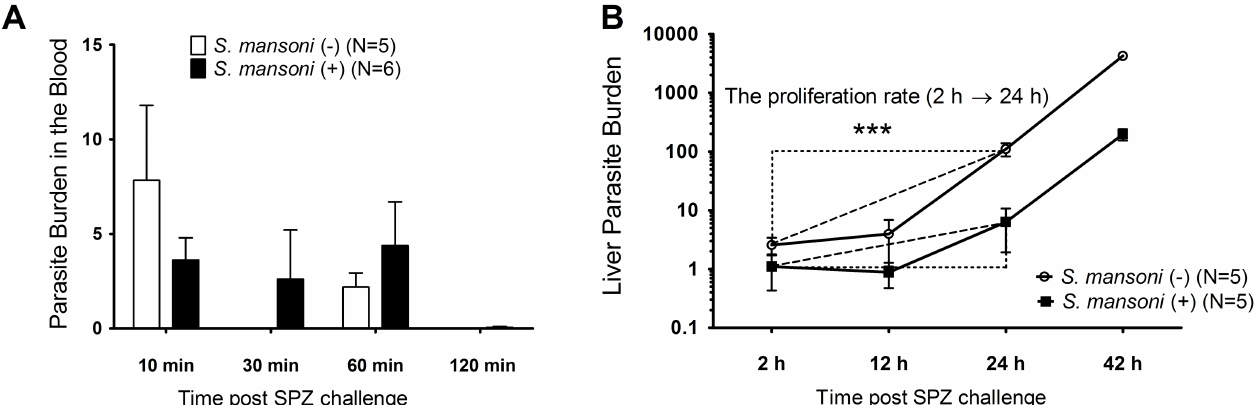
Fig 3. Plasmodiumyoelii parasite density in the blood and liver. Copy number of P . yoelii 18s RNA gene per 1×10 6 mouse G3PDH gene measured at 42 h post sporozoite inoculation. Female BALB/c mice (N = 5) infected with 50 Schistosoma mansoni -cercaria 10 weeks previously were challenged with 1,500 SPZ of P . yoelii along with S . mansoni -non-infected controls. (A) P . yoelii parasitaemia in the blood. (B) P . yoelii parasite density and proliferation in the liver. (cid:3)(cid:3)(cid:3) P < 0.001, Student’s two-tailed t-test, t = -6.316, df =